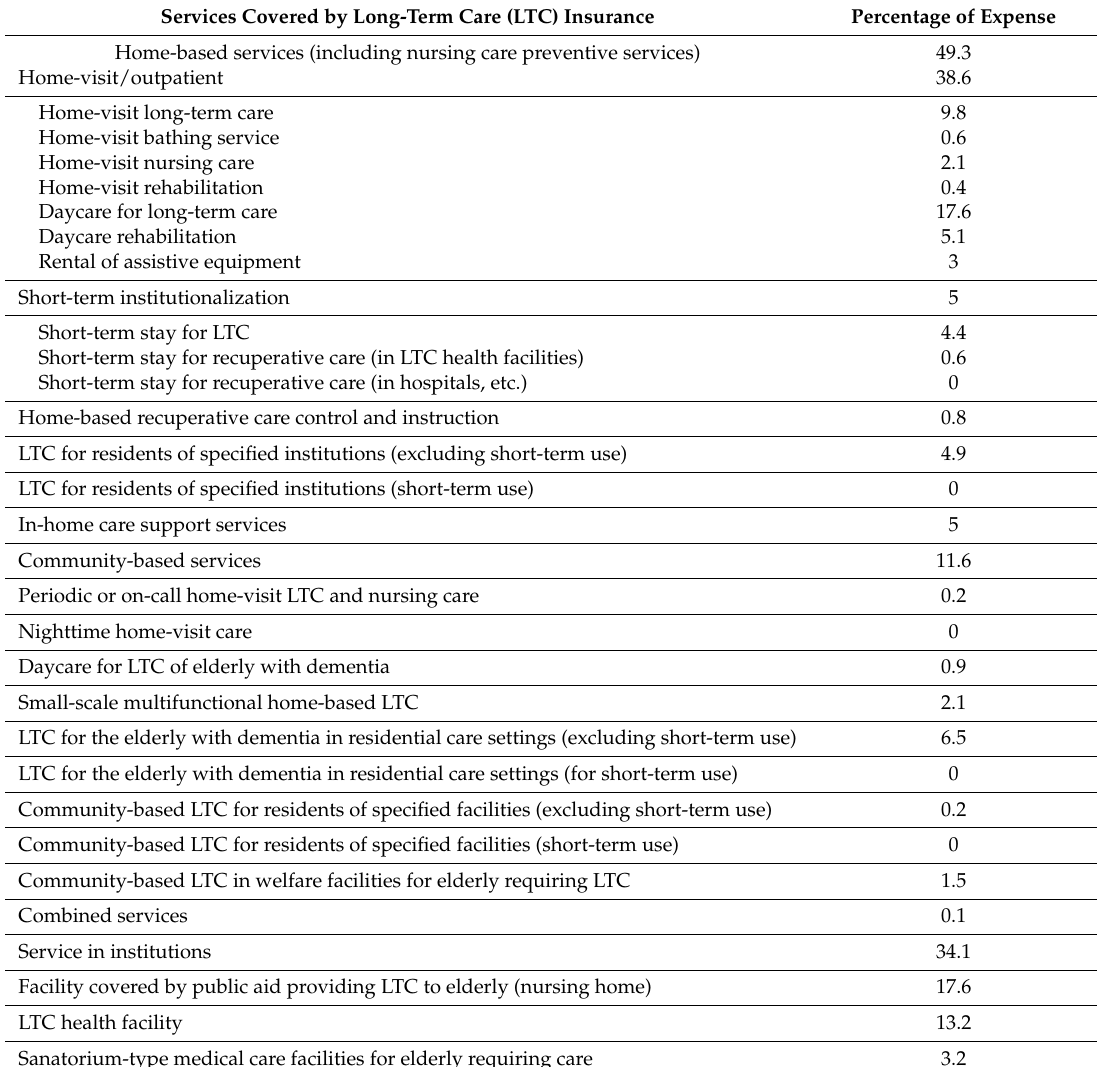
Table 2. Detailed menu of long-term care and preventive long-term care services